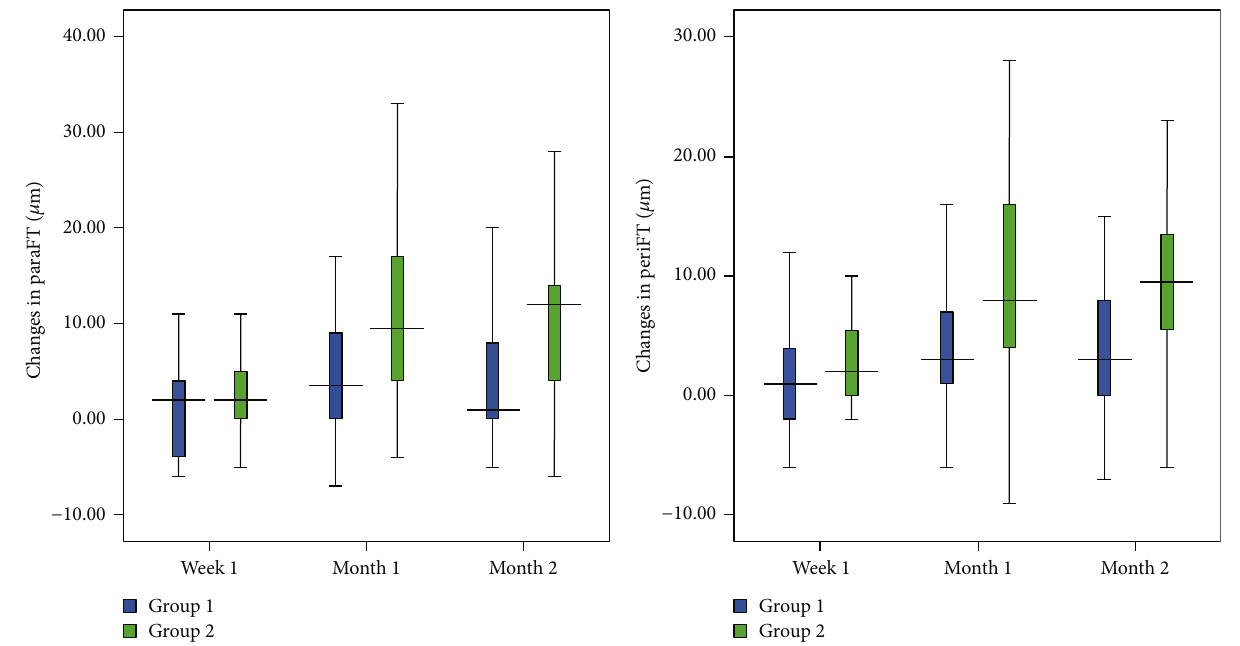
Figure 2: Changes in parafoveal thickness (ParaFT) and perifoveal thickness (PeriFT) in group 1 (ketorolac/steroid group) and group 2 (steroid group). The ParaFT and PeriFT were signi fi cantly lower in group 1 at the fi rst and second months postoperatively (ParaFT P = 0 015 , P = 0 015 ; PeriFT P = 0 048 , P = 0 017 ,